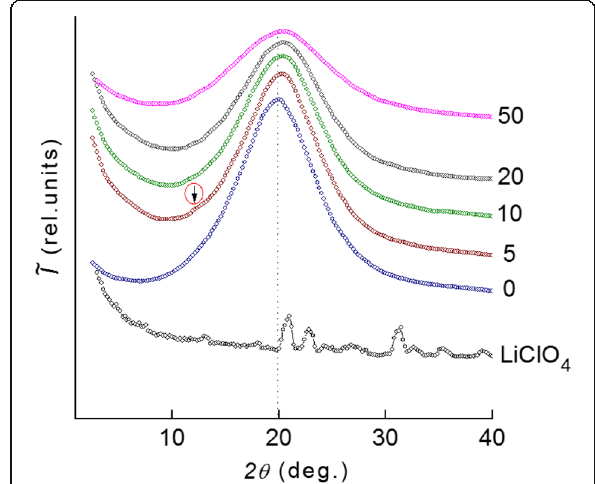
Fig. 2 The WAXS studies of the DEG-1/LiClO 4 systems. The wide- angle X-ray diffraction patterns of a lithium perchlorate salt LiClO 4 and systems with the different salt content (shown near curves)